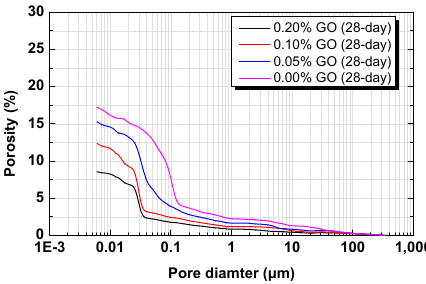
Figure 15. Pore size distribution of RFA mortar at 28 days.